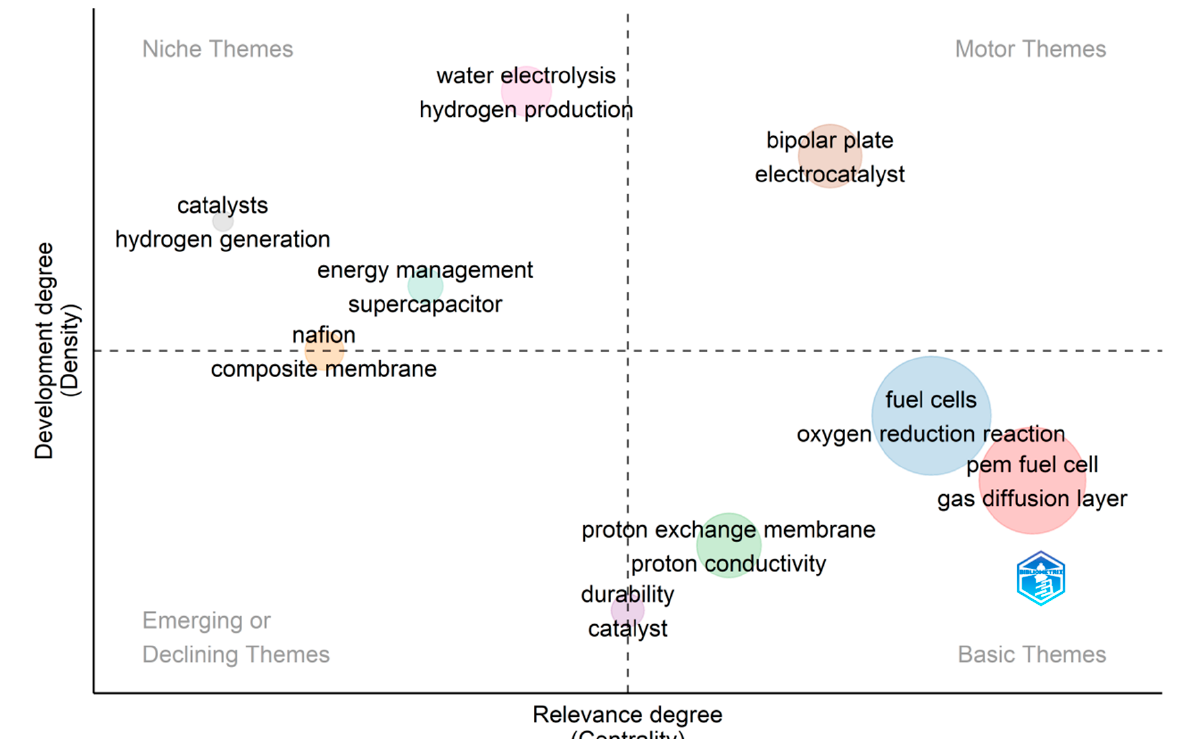
Figure 21. Thematic map based on 500 most cited PEMFC articles.